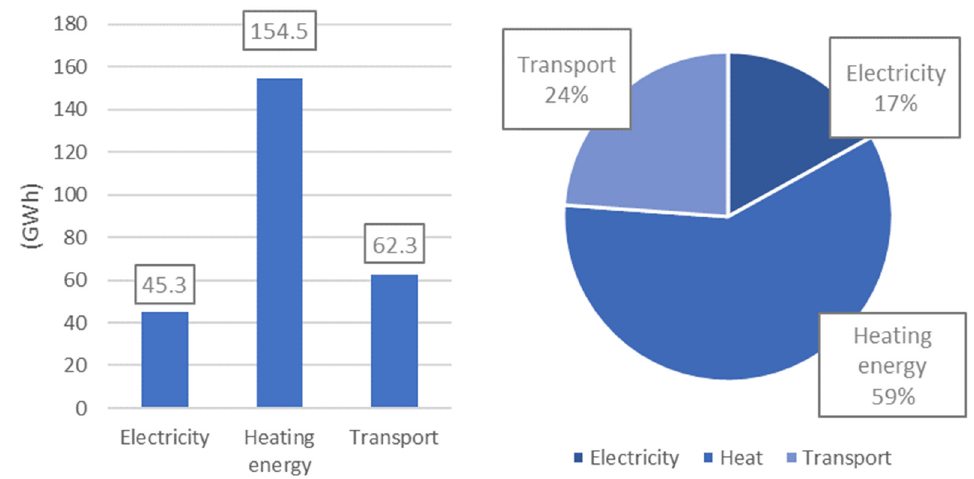
Figure 3. Annual average energy consumption of the case study city.